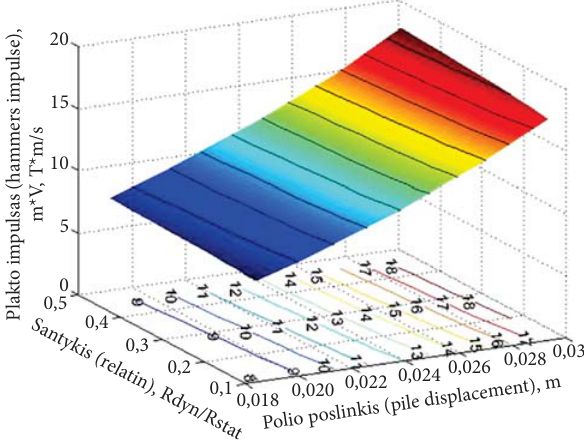
Fig. 5. Pile displacement versus foundation dynamic and static strengh relation versus hammers